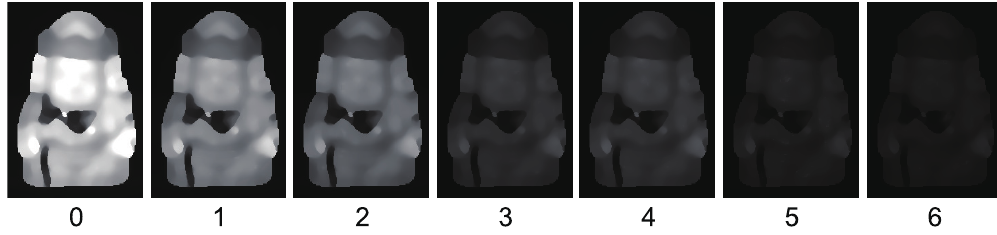
Figure 23. The results for buddha object, which only causes strong specular reflection. Estimated albedo is shown, which is smooth enough.